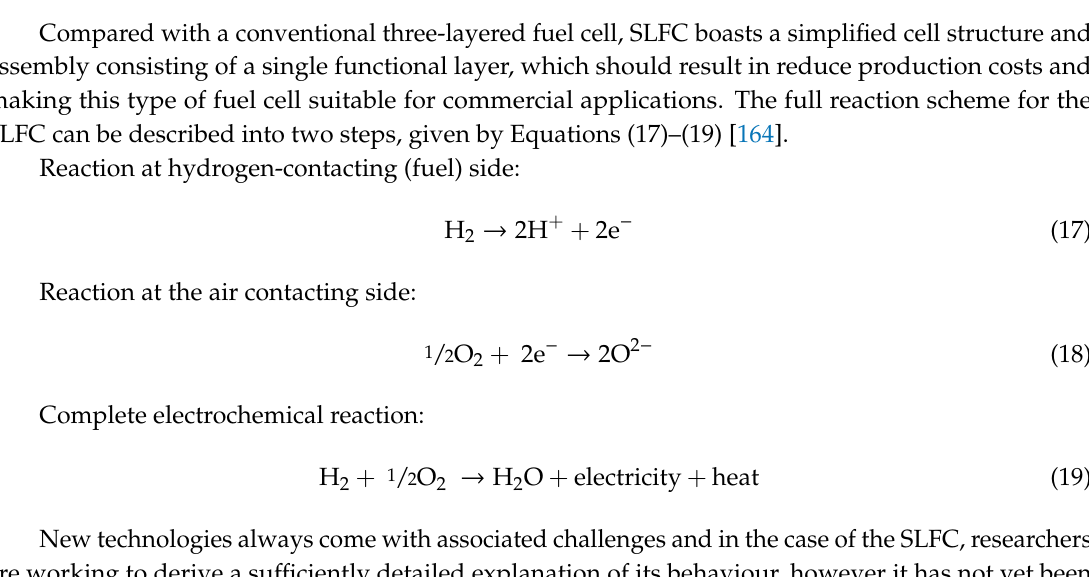
Figure 15. The single component fuel cell, which is comprised of mixed conducting materials inside the the layer.